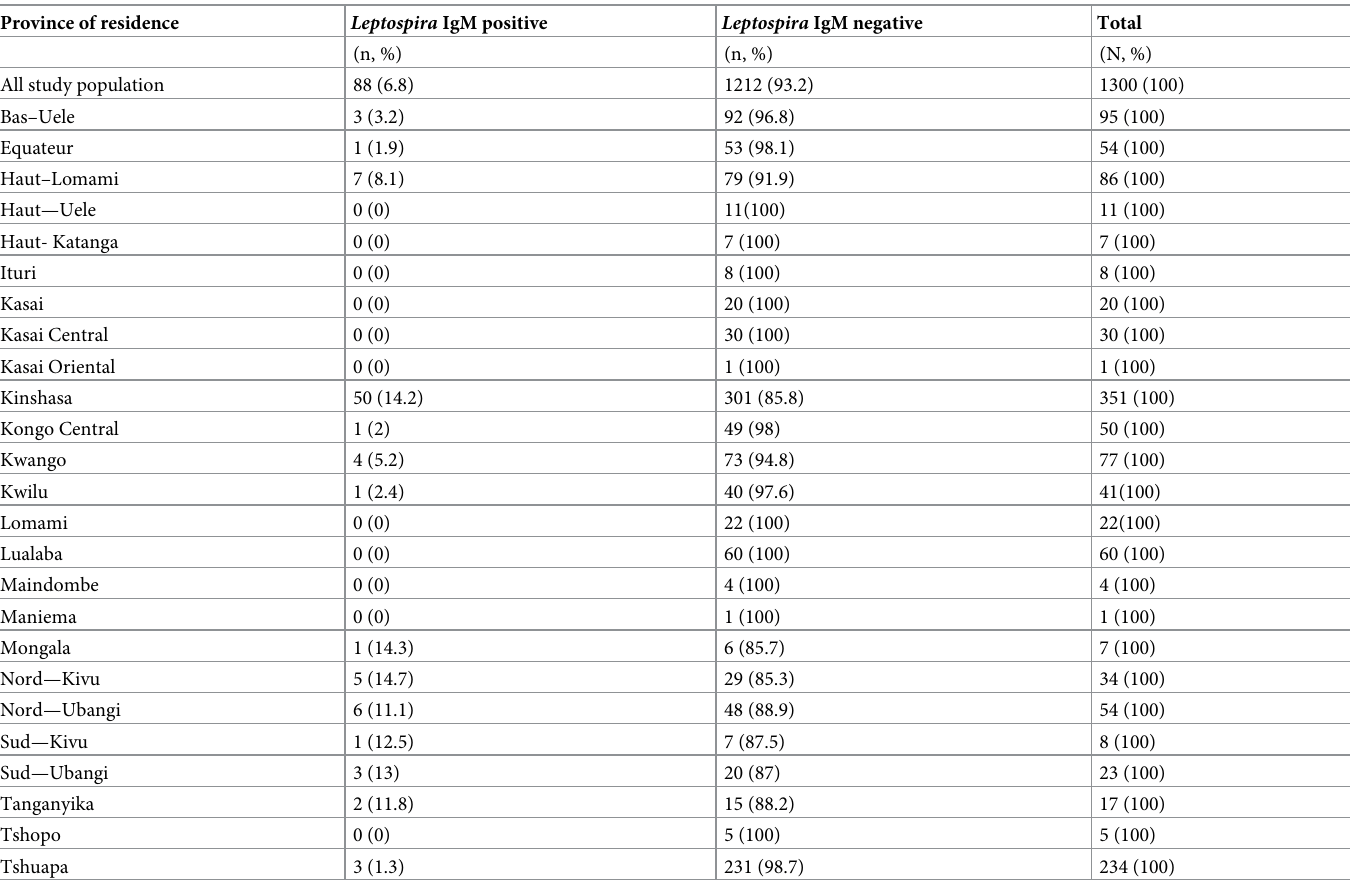
Table 4. Distribution of DR. Congo provinces by leptospiral serology status